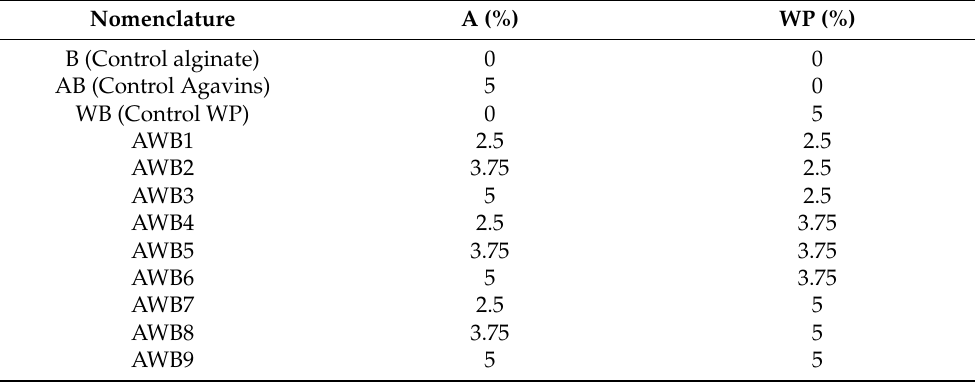
Table 1. Nomenclature and composition of the